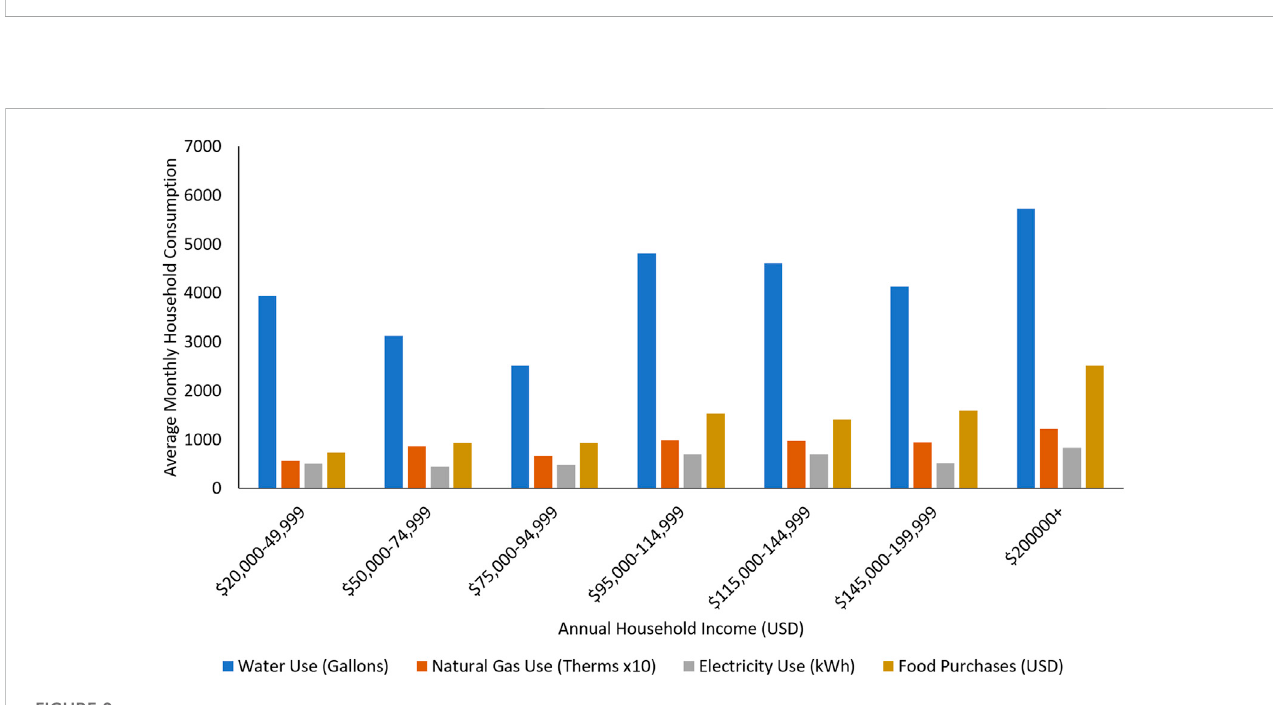
FIGURE 8 Average monthly greenhouse gas emissions by FEW consumption category and household size in